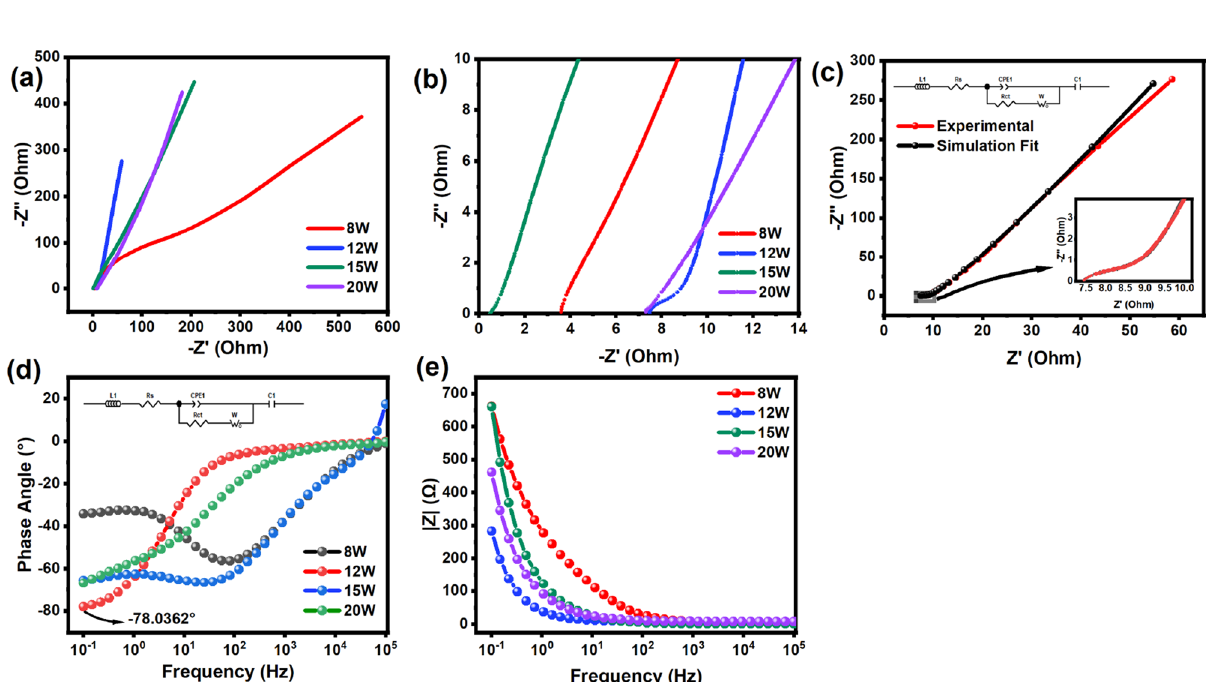
Figure 7. EIS was conducted on all samples to understand electrode conductivity ( a ) Nyquist plot shows P12 with near 90-degree slope at a lower frequency ( b ) High-resolution EIS for all samples to understand internal resistance ( c ) Simulated fit of P12 sample ( d ) Bode plot indicate P12 reaching near 90 degrees ( e ) Absolute impedance vs frequency curve proving least electrode resistance for